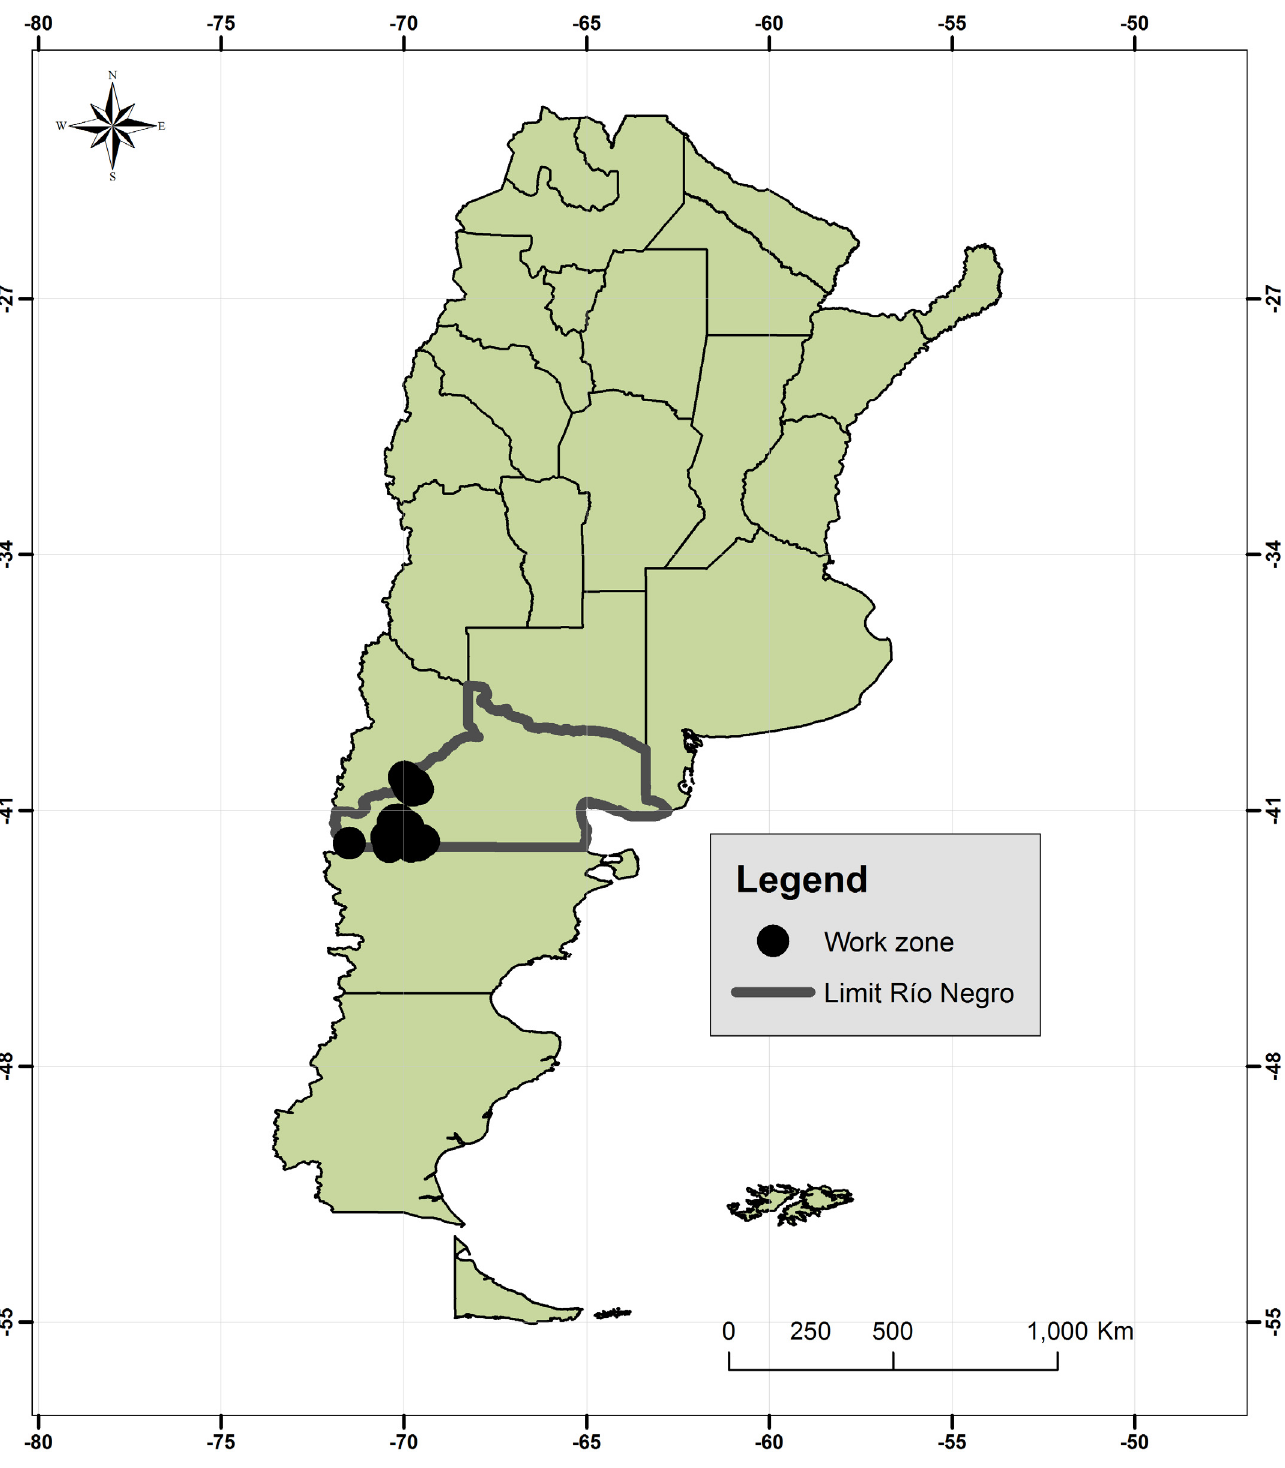
Fig 1. Geographic area for CE control programme showing sheep farm in control and vaccination areas. Río Negro, Argentina.